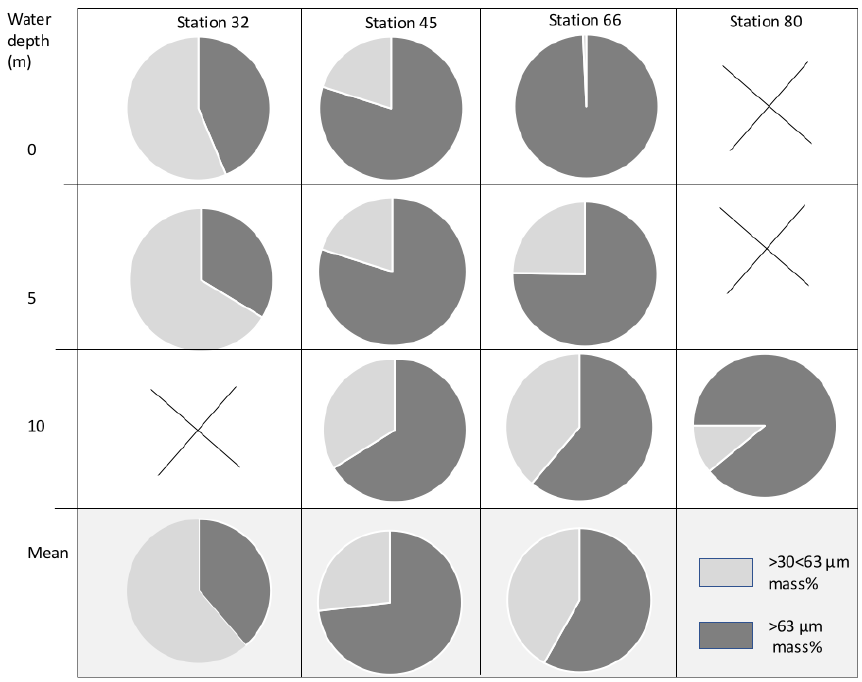
Figure 3. Proportional mass (%) of cryogenic gypsum for the size fractions > 30 < 63 and > 63µm for all ROV samples.